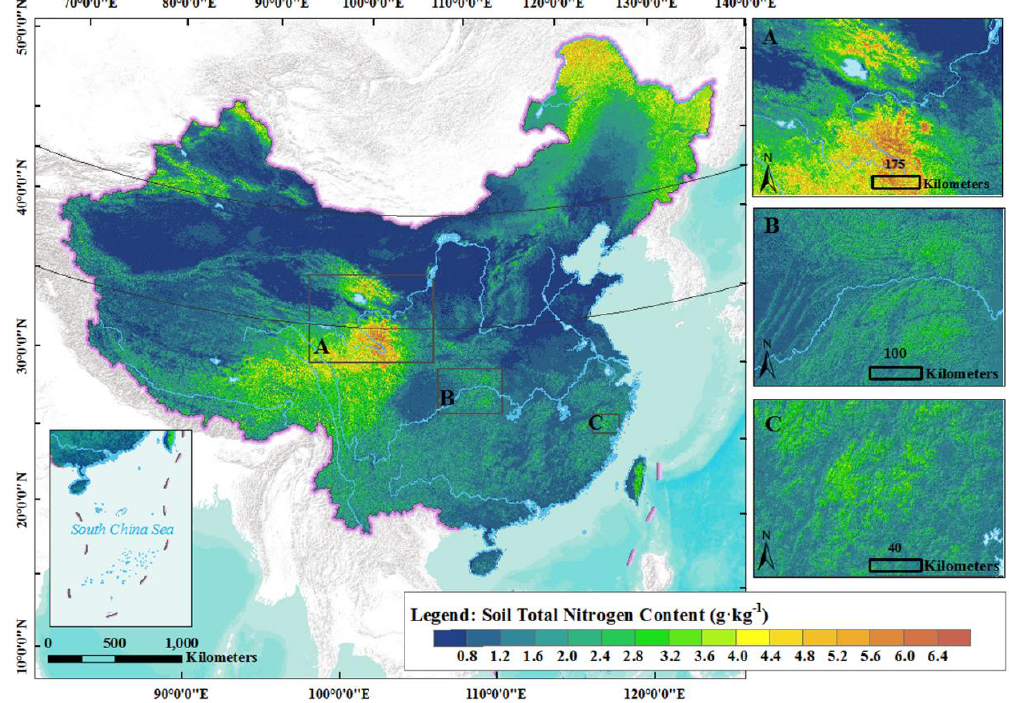
Figure 6. The soil total nitrogen content in the topsoil (0–20 cm).